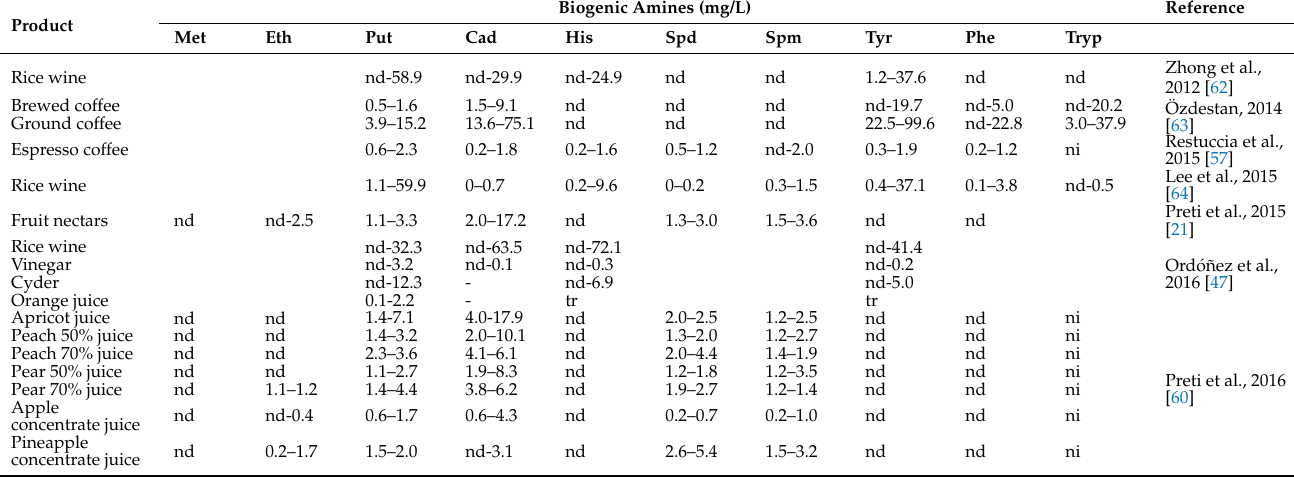
Table 4. Range (min–max concentrations) of biogenic amines in non-fermented